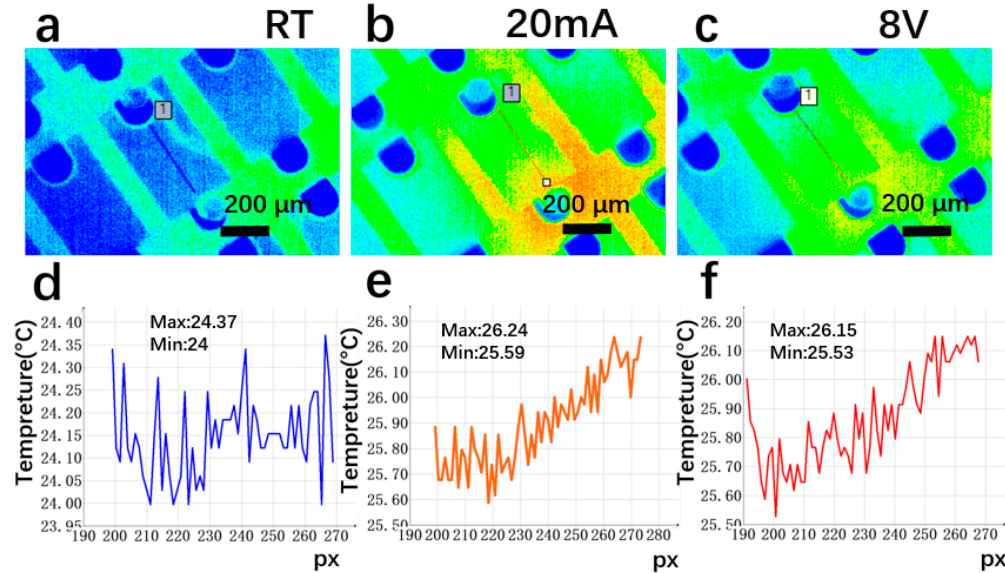
Figure 10. Temperature distribution of platinum-annealed LEDs (sample 3). ( a , d ): room temperature; ( b , e ): constant current at 20 mA; and ( c , f ): constant voltage at 8 V.